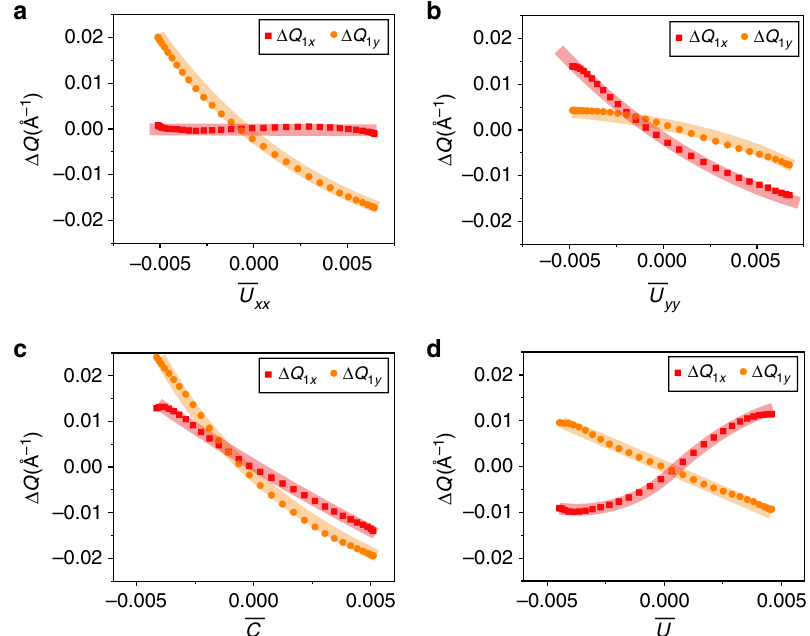
Fig. 4 The shift of the QPI peaks as a function of average strain. The absolute change in the QPI scattering wavevectors Δ Q 1 x and Δ Q 1 y plotted against the average values of: a u xx , b u yy , c C , and d